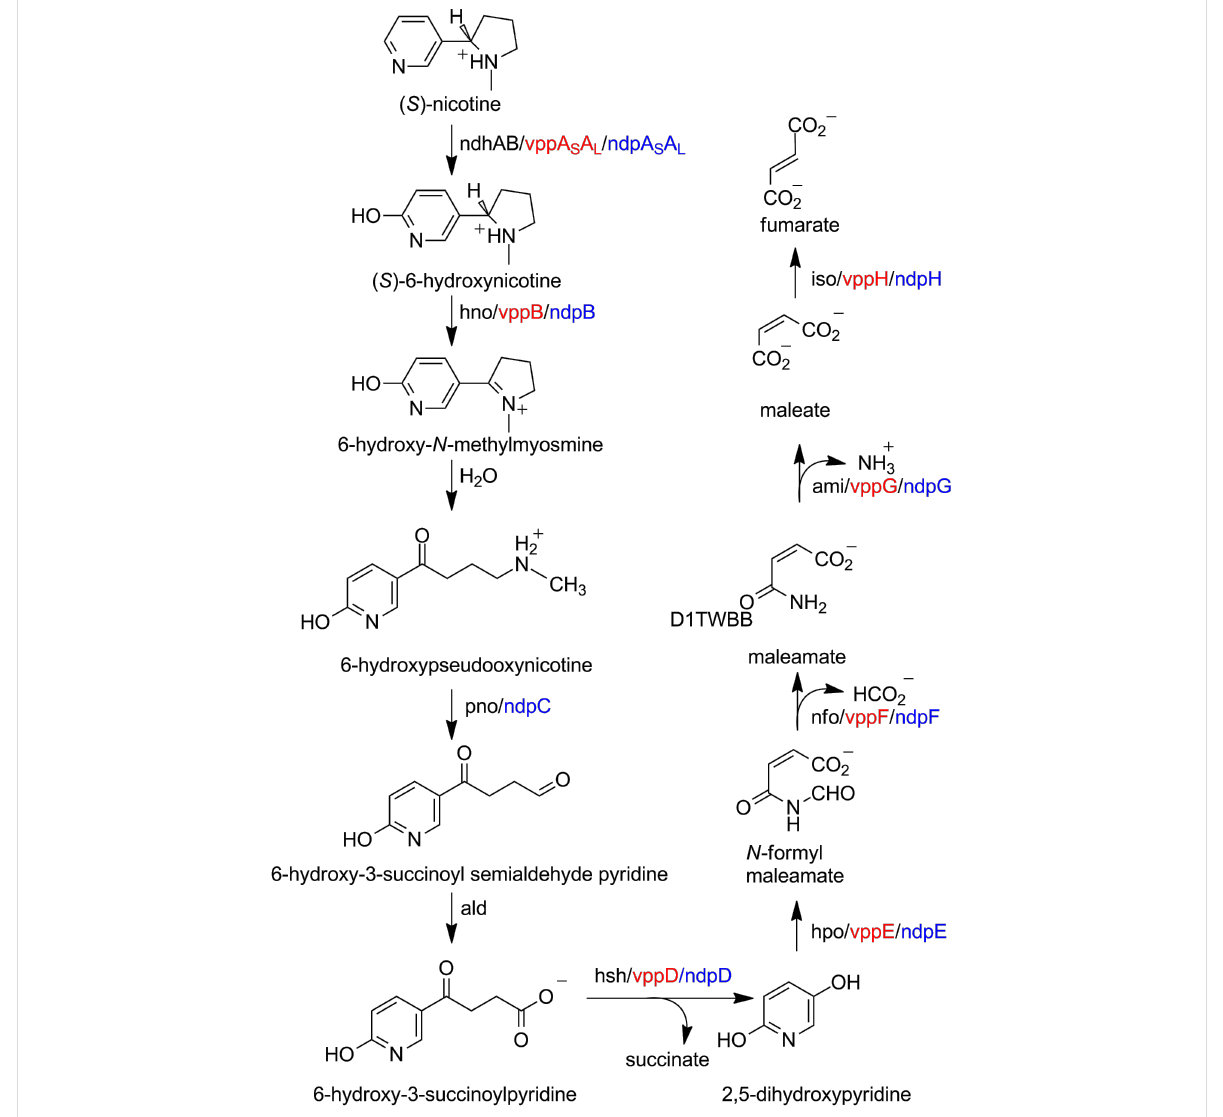
Scheme 11: Hybrid pyridine/pyrrolidine pathway for nicotine metabolism in Agrobacter tumefaciens S33 (black), Ochrobactrum sp. SJY1 (red), and Sphingomonas melonis Ty (blue).